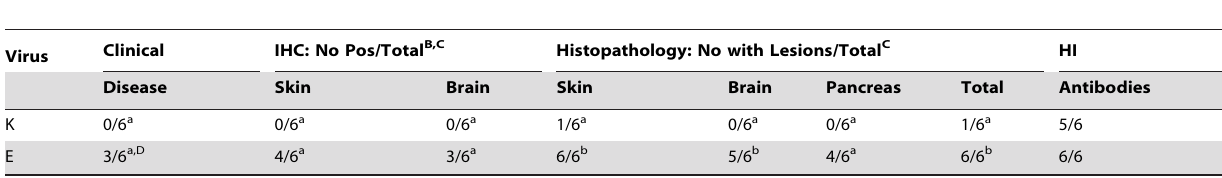
Table 4. Clinical, pathological and virological responses in chickens inoculated with LP VN/1203/K or LP VN/1203/E and monitored for 14 days pi A